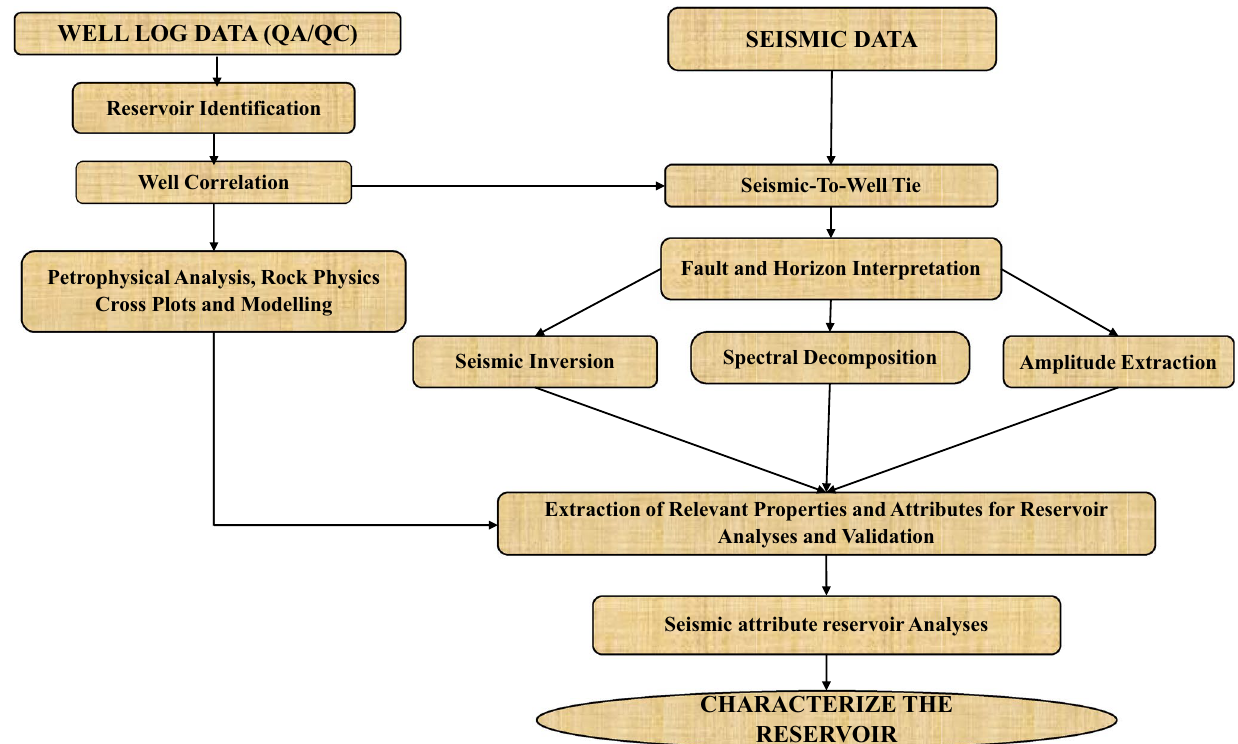
Fig. 4 Schematic workflow of the